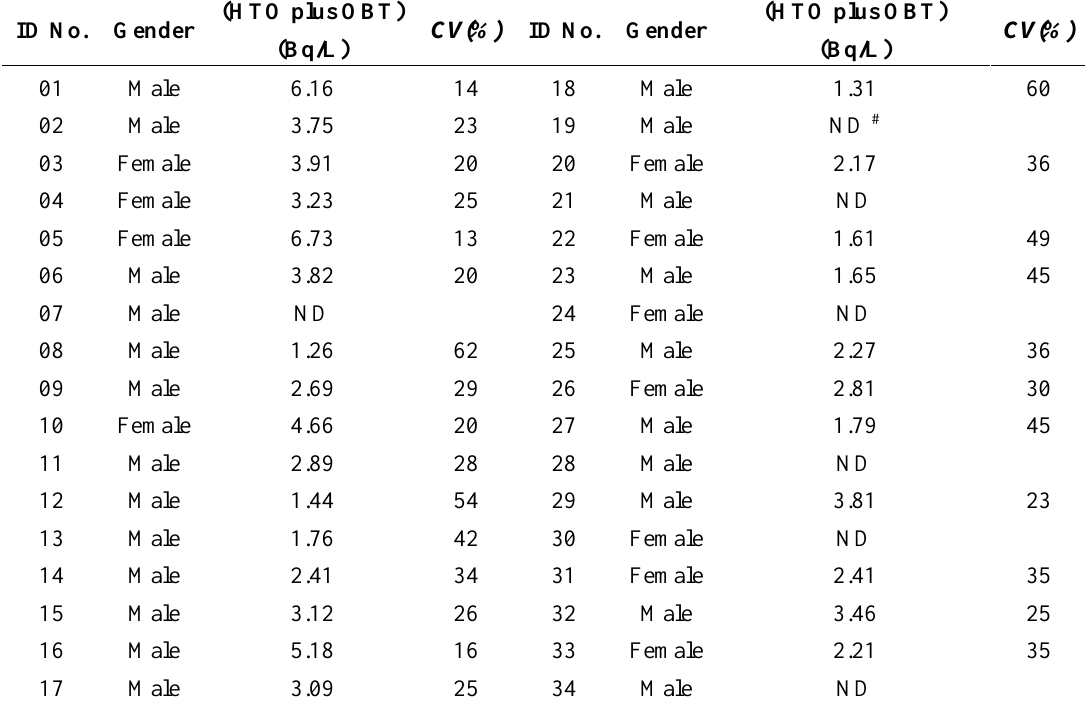
Table 1. The concentration of